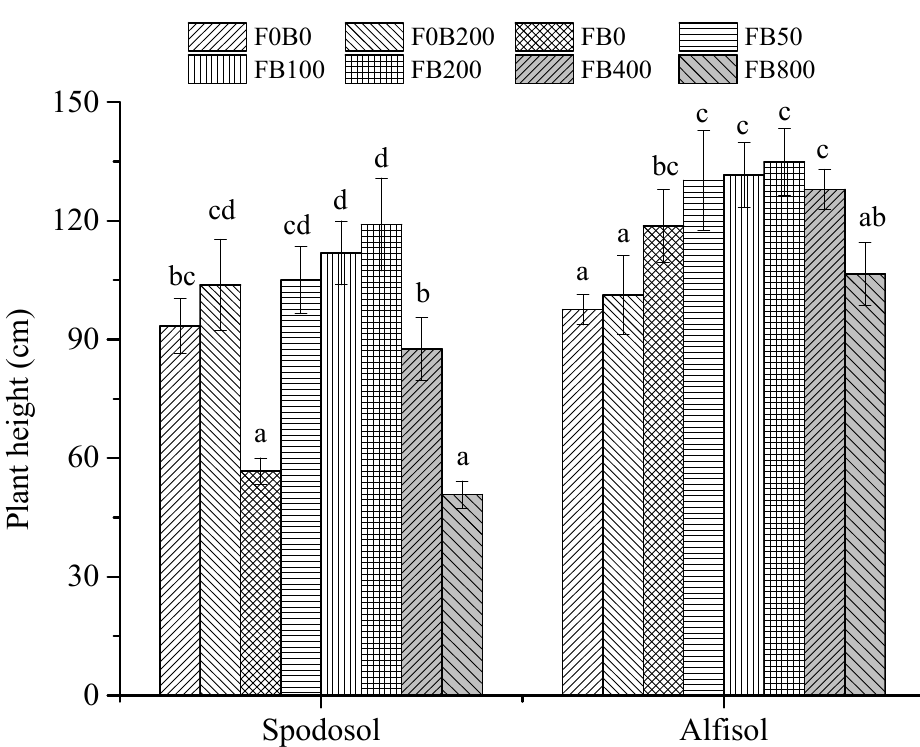
Figure 1. Effects of CNPs on the plant height of corn grown in Spodosol and Alfisol soils on the 49th day after transplanting. F0B0, control (without fertilizers and CNPs); F0B200, without fertilizers and with CNPs at 200 mg kg − 1 soil; and FB0, FB50, FB100, FB200, FB400 and FB800 represent those with fertilizers and CNPs at application rates of 0, 50, 100, 200, 400 and 800 mg kg − 1 soil, respectively. Error bars represent the standard error of the mean ( n = 5). The letters a, b, c, and d indicate statistically significant difference at p < 0.05 within each group comparison between the treatments. Bars with no common letters are significantly different ( p < 0.05).